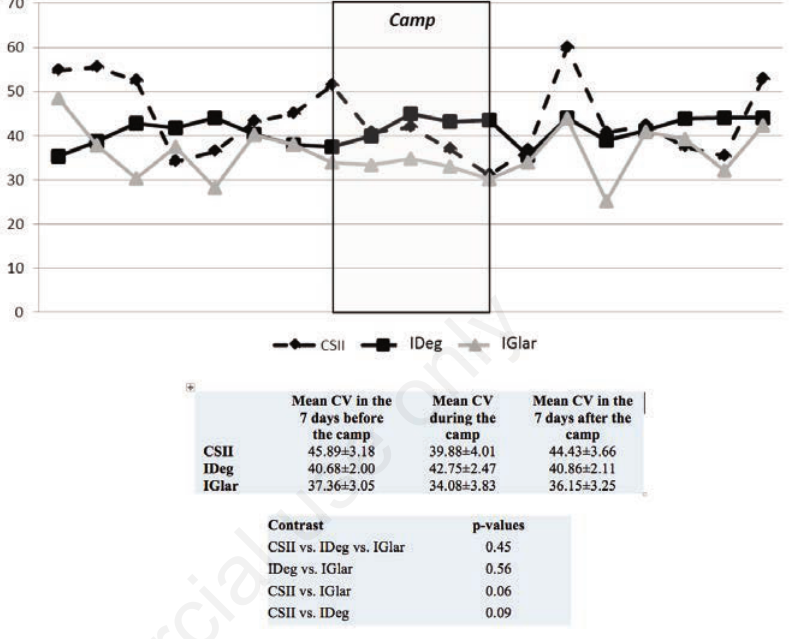
Figure 2. Trends of coefficient of variation of blood glucose during the camp and in the seven days before and after the camp.